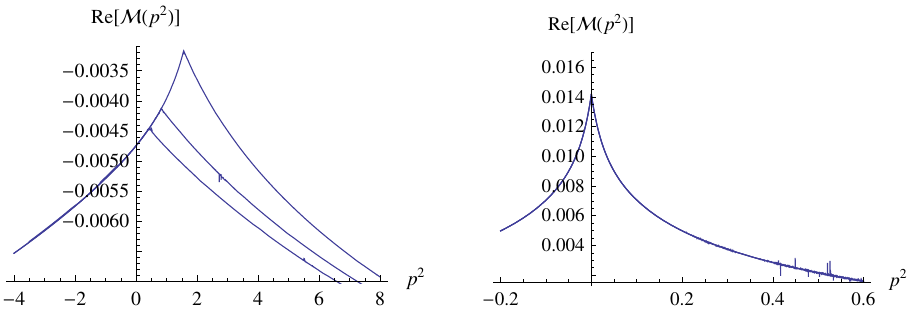
Figure 20 . Four-dimensional LW fakeon: numerical results from the nonanalytic Wick rota- tion (with no domain deformation) for (right picture).